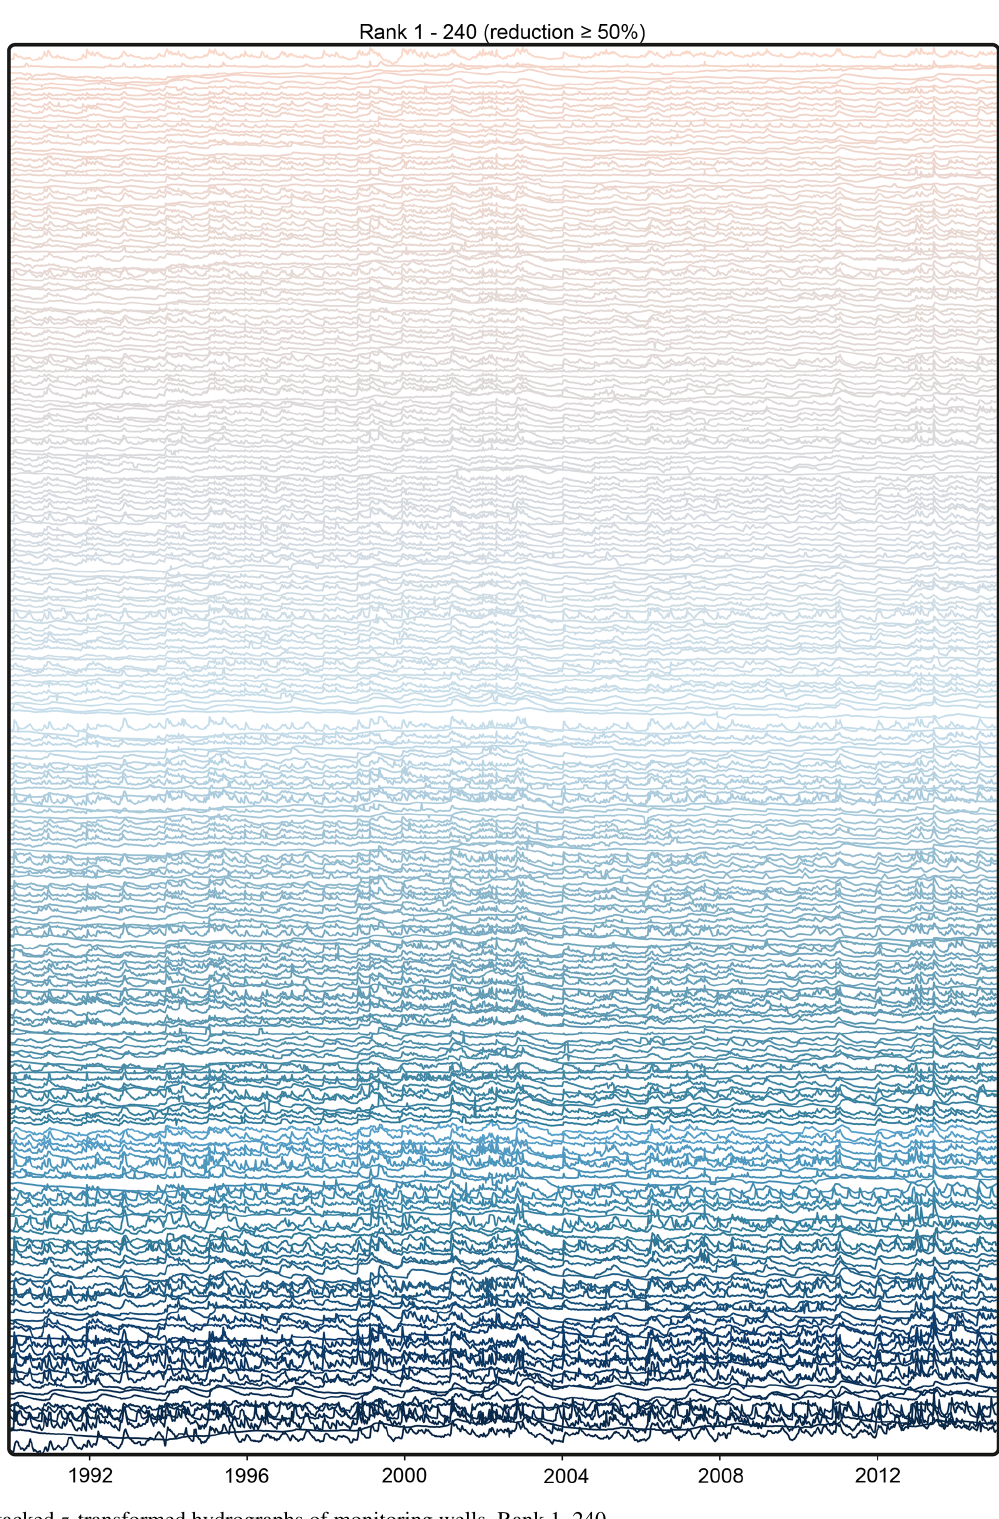
Figure A2. Stacked z -transformed hydrographs of monitoring wells. Rank 1–240.